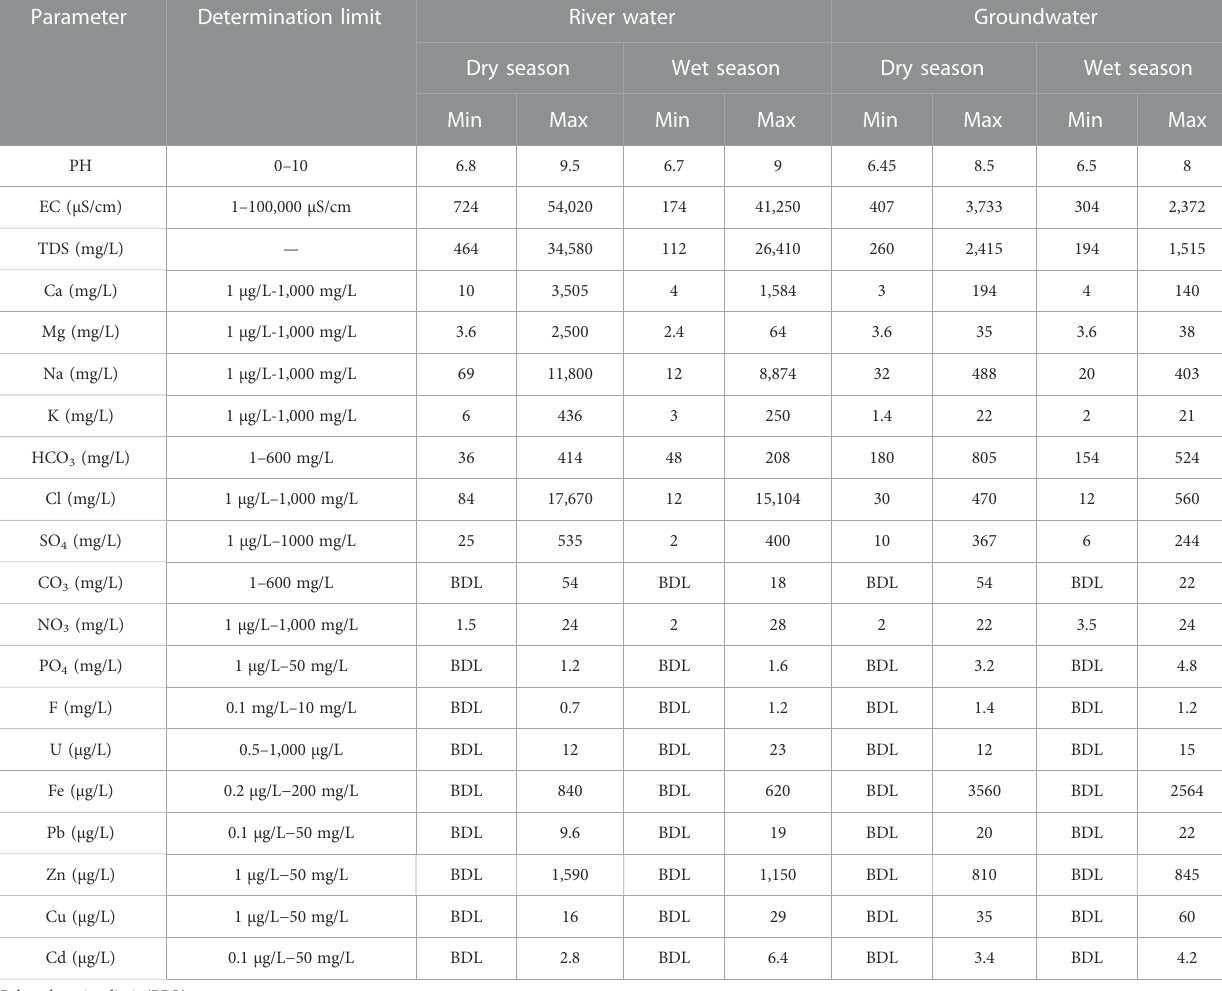
TABLE 1 Summary of physico-chemical parameters of river water and groundwater. Parameter